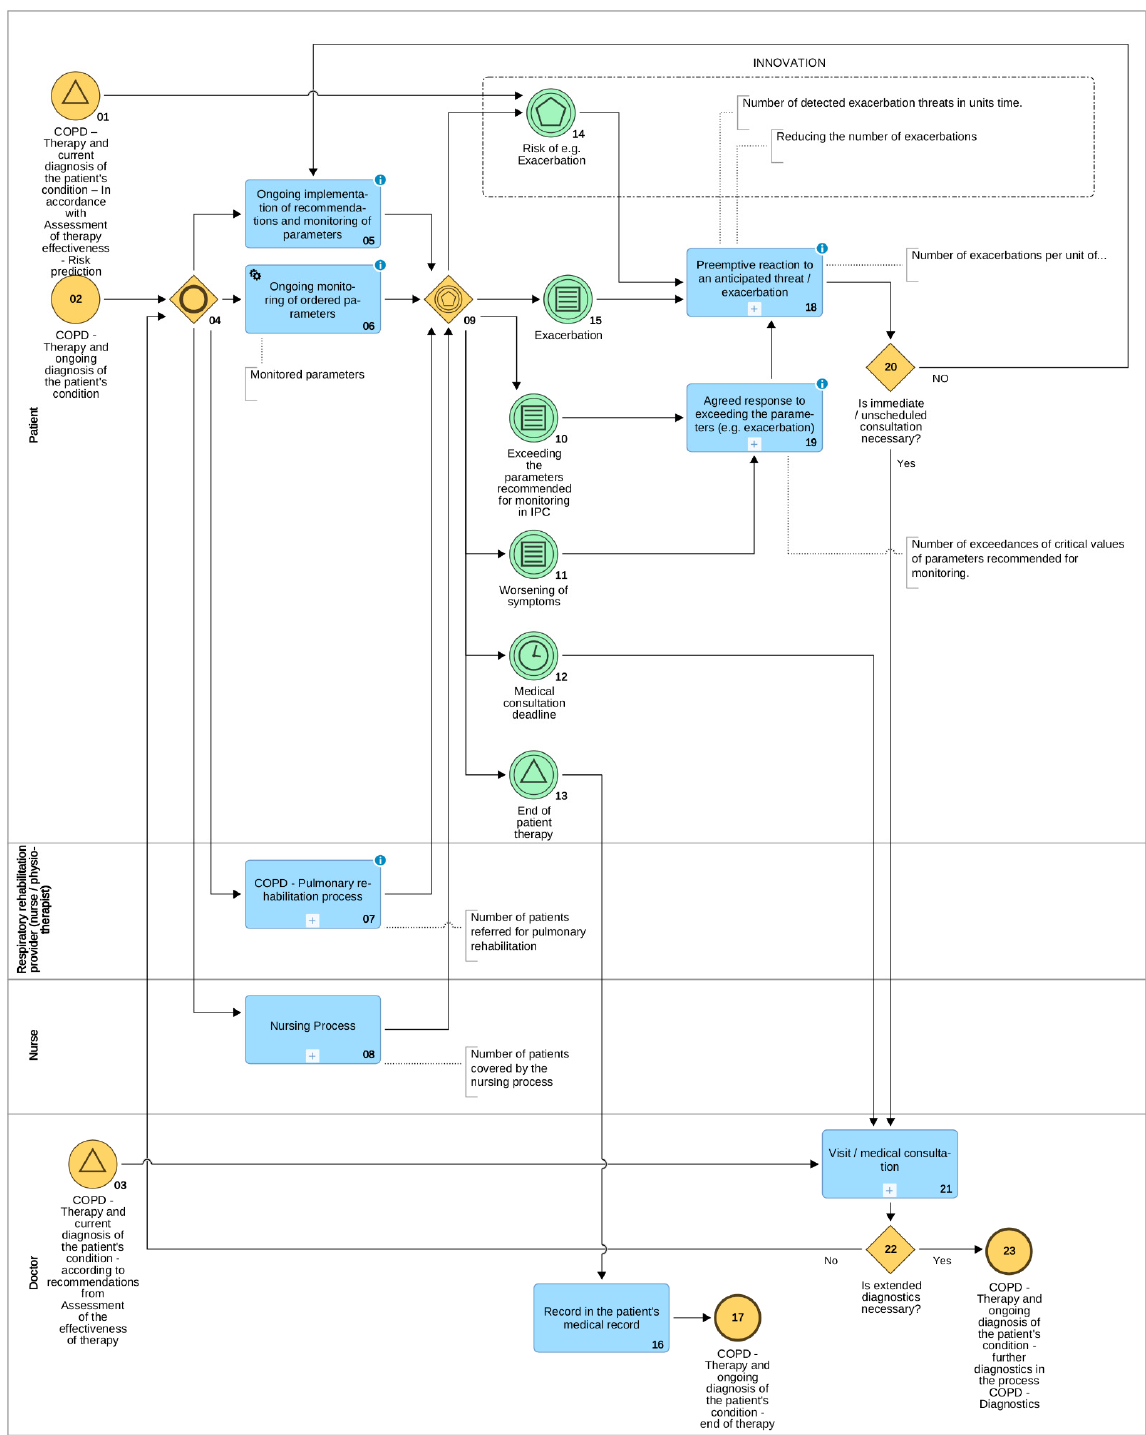
Figure 3. Process COPD—Therapy and ongoing diagnosis of the patient’s condition—patient process, in which the doctor and others (only) participate (by ADONIS).